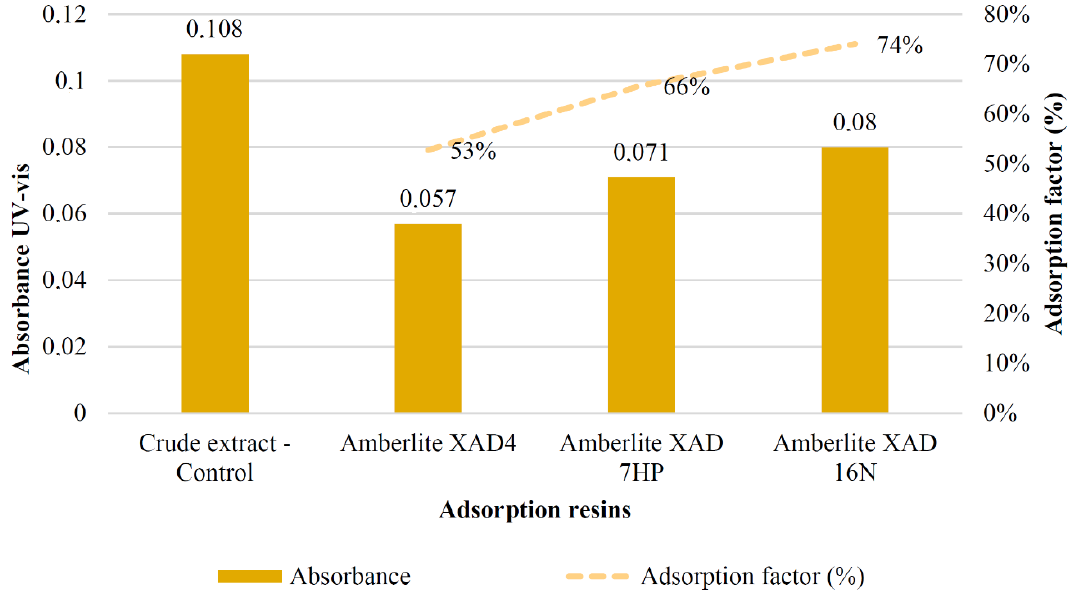
Figure 3. Adsorption profile in absorbance by ultraviolet-visible spectroscopy (UV-Vis) of LP extract by using macroporous resins with different polarity.